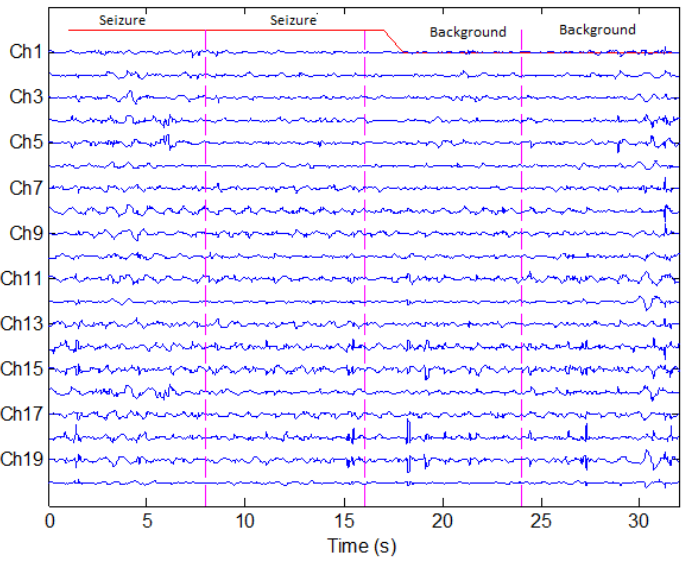
Figure 6. An example of the database showing seizure vs. background